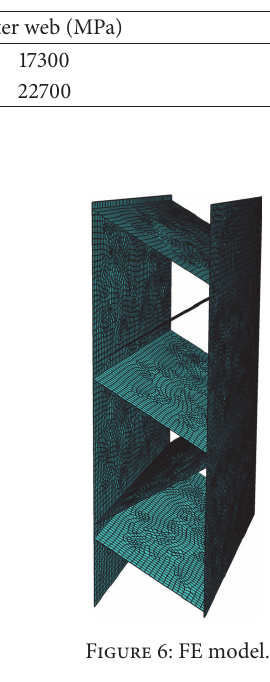
Figure 3: Experimental investigation [7]. Table 1: Mechanical properties used for FEM modeling.